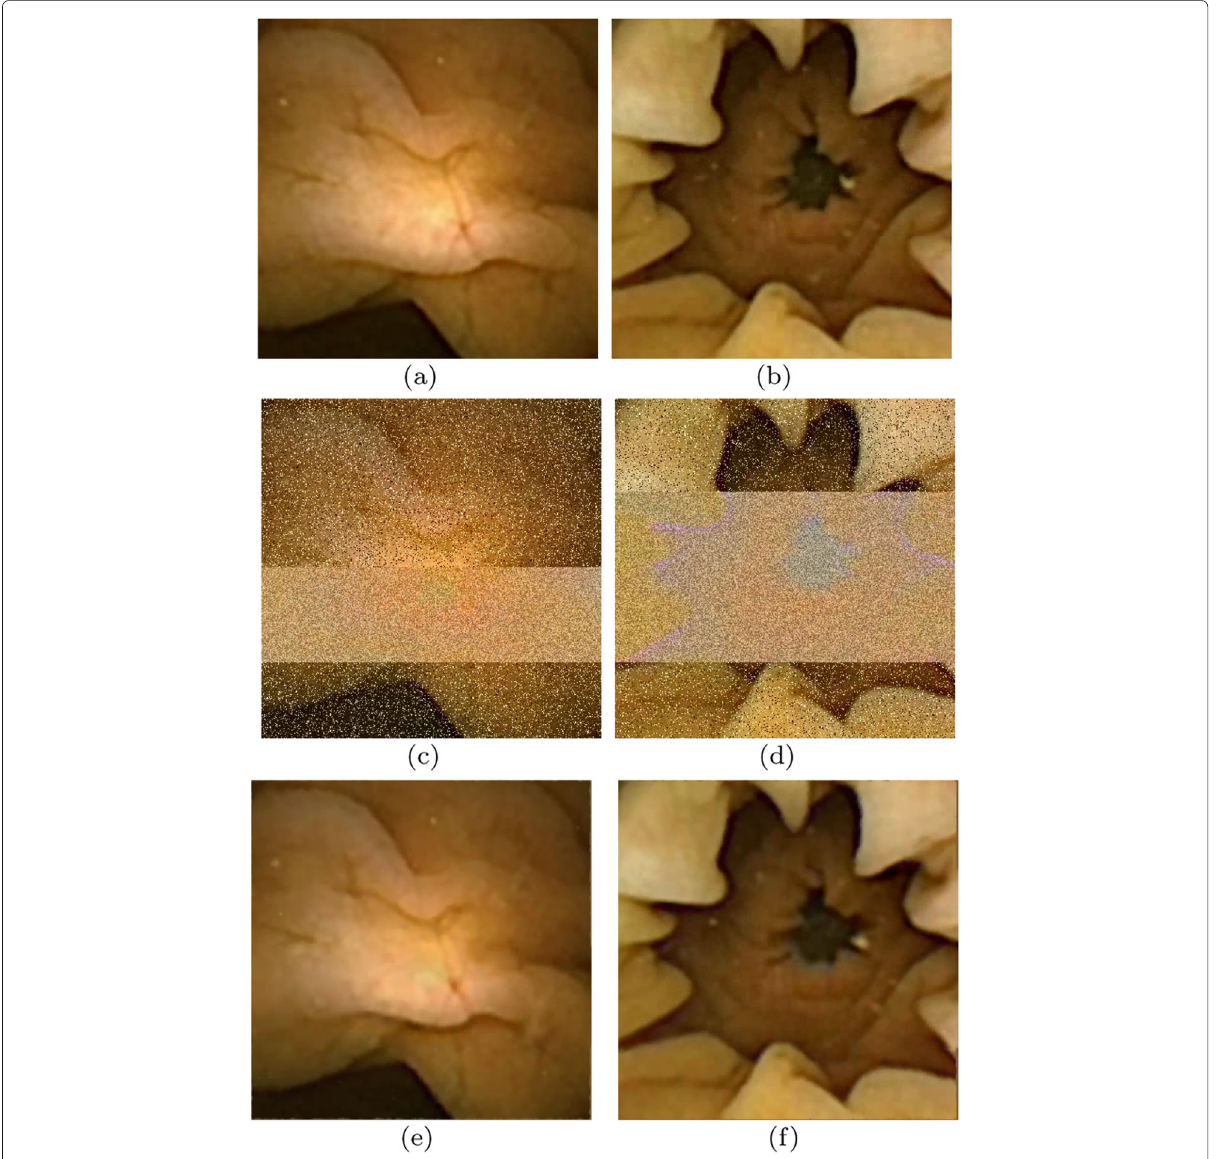
Fig. 8 Simultaneous correction of single pixel errors and error blocks. a Original image 1. b Original image 2. c Noisy image 1, SSIM = 0.005. d